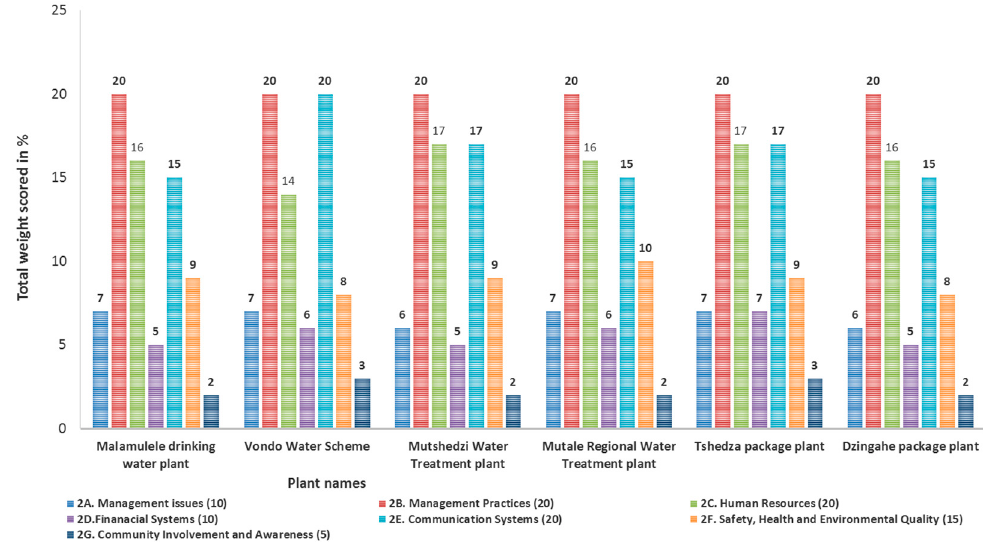
Figure 4. Scoring of water treatment plants based on non-technical compliance assessment during the second assessment between November and December 2010.